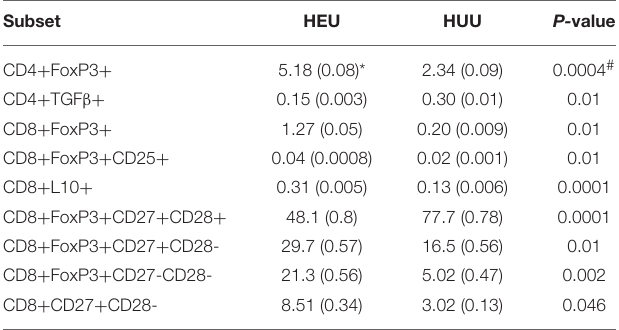
TABLE 1 | T cell phenotypic subsets significantly different between 26 HEU and 17 HUU. Subset